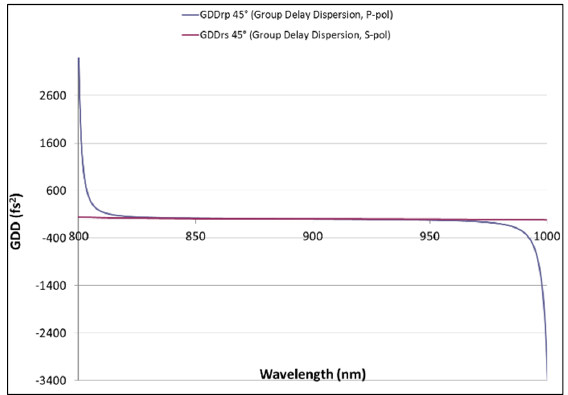
Figure 5. Group delay dispersion (GDD) on reflection as a function of wavelength for 45° AOI, Spol and Ppol, for the BBHR coating design.